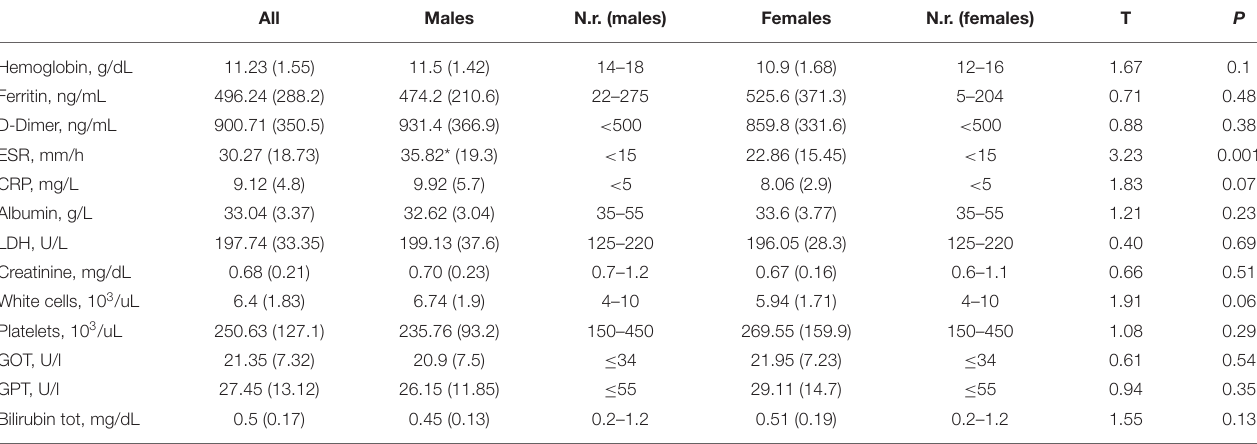
TABLE 2 | Hematological data from all patients and according to gender after 60 days from hospital discharge. All Males N.r. (males) Females N.r. (females)